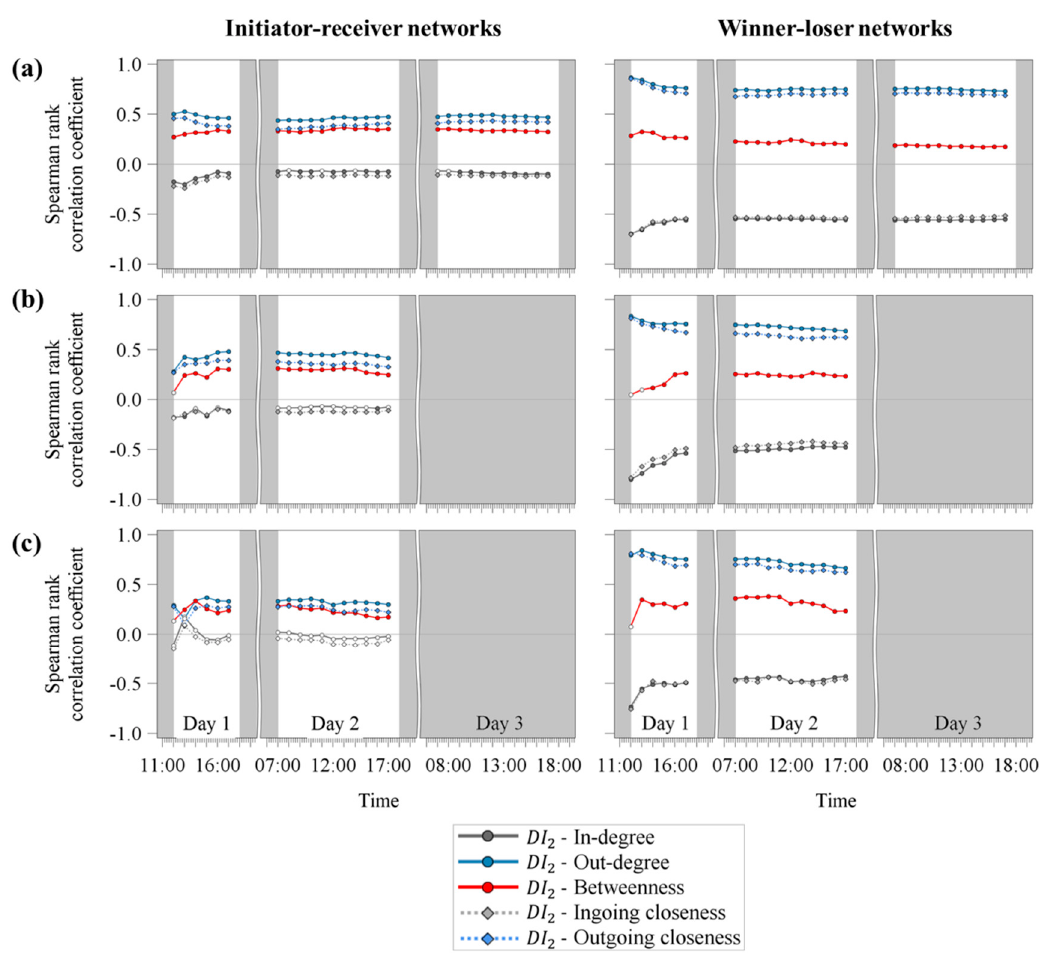
Figure 4. Temporal development of the Spearman rank correlation coefficients between the index ( DI 2 ) and the centrality parameters for ( a ) weaned piglets, ( b ) fattening pigs and ( c ) gilts. Filled markers indicate significant correlation coefficients ( p < 0.05). Grey shaded areas are times without video observation.